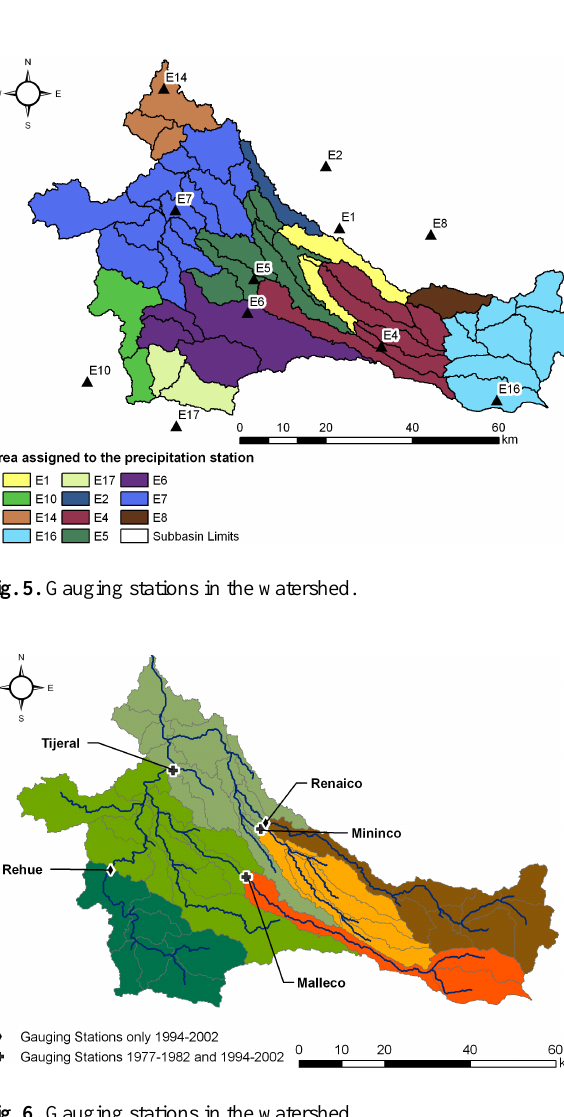
Fig. 6. Gauging stations in the